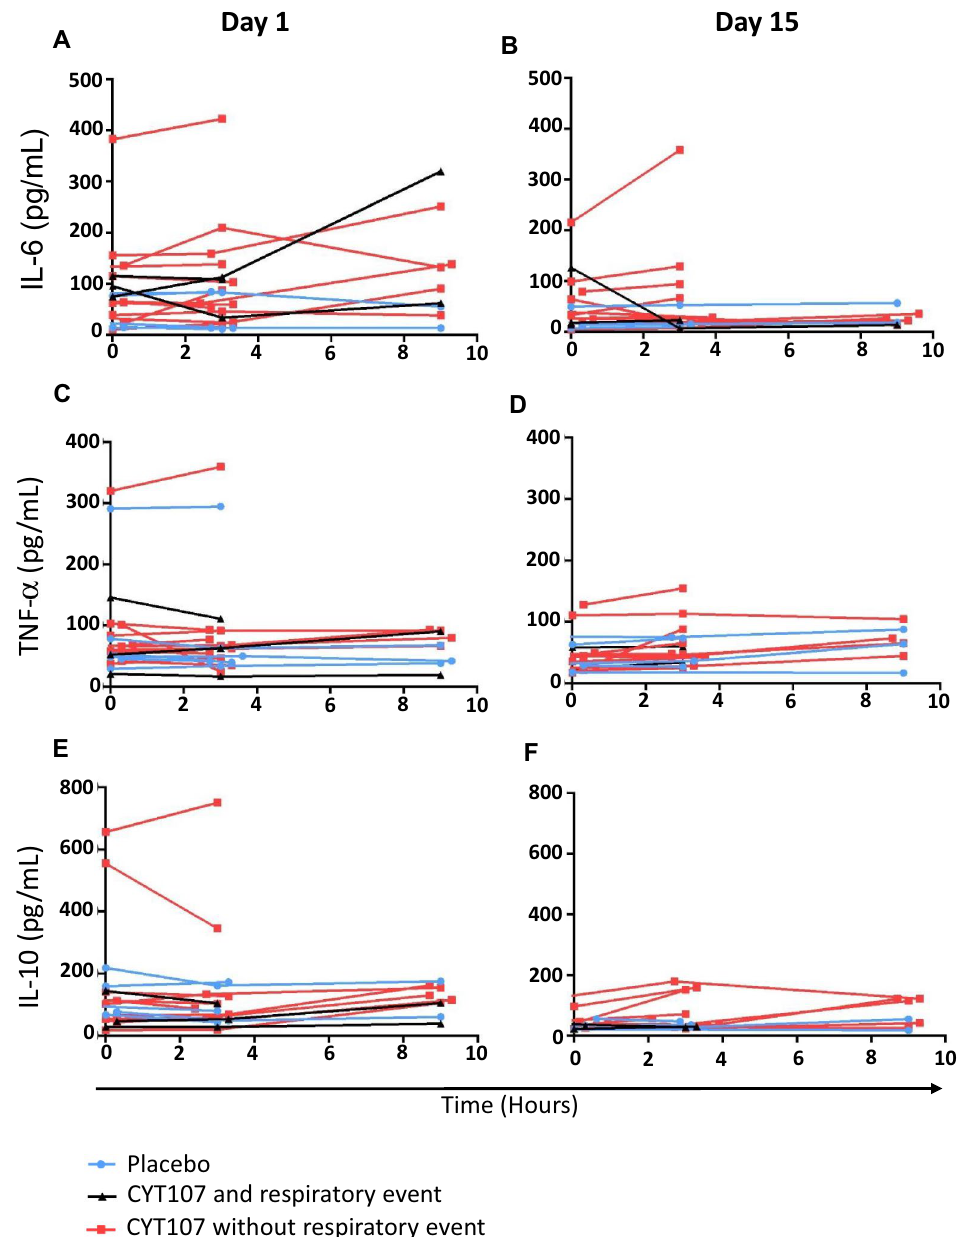
Fig. 3 Effect of CYT107 on circulating cytokines. Plasma concentration at day 1 and day 15 of the pro‑inflammatory cytokines IL‑6 ( A , B ) and TNF‑a ( C , D ) and the anti‑inflammatory cytokine IL‑10 ( E , F ). Placebo group individuals are in blue. Patients that received CYT107 and had a respiratory event are in black. Patients that received CYT107 and did not have a respiratory event are in